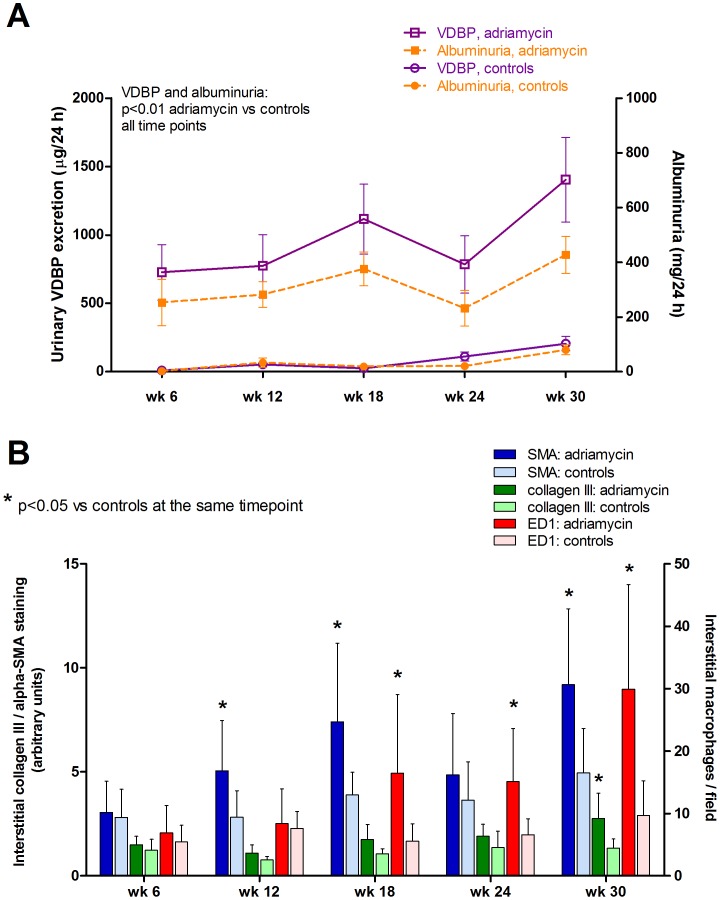
Urinary vitamin D binding protein (uVDBP) and albuminuria levels, and structural renal changes over time in adriamycin and control rats. A.Graphs illustrating the development of albuminuria (orange) and uVDBP (purple) over time in the unilateral adriamycin nephropathy model and in sham-operated control animals. B. Development of tubulointerstitial damage as reflected by interstitial α-smooth muscle actin (blue bars) and collagen III staining (green bars), and interstitial macrophage accumulation (red bars) in adriamycin rats (dark bars) and controls (light bars).